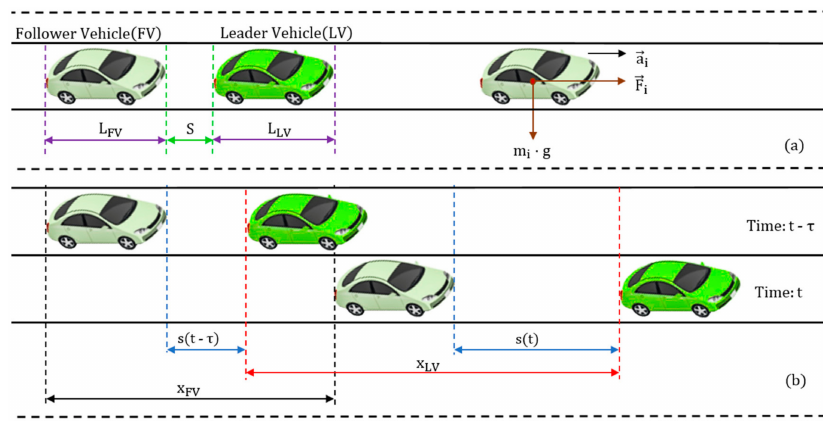
Figure 1. Car-following concept: ( a ) vehicle characteristics; ( b ) parameters of interest and vehicles behavior. The listed parameters will be used further in the car-following model